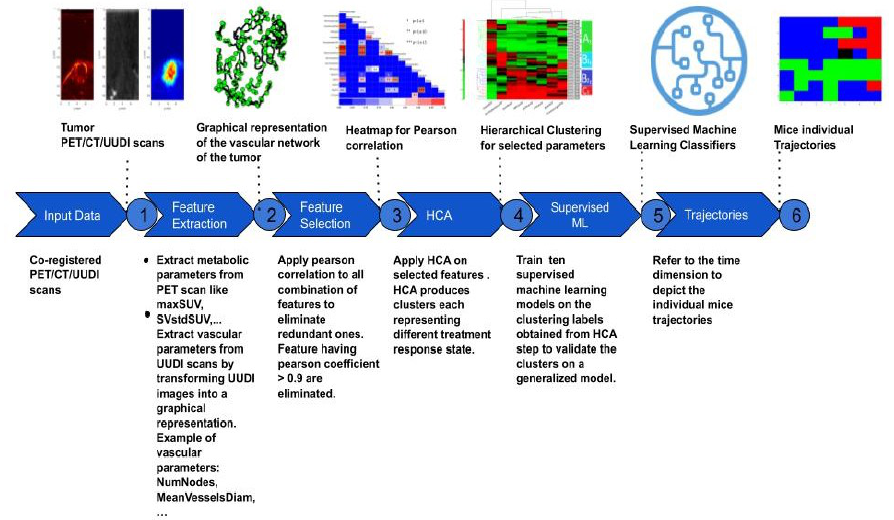
Figure 1. Process diagram showing the framework pipeline. Images were co-registered and processed to extract features describing the metabolic, vascular, and morphological components of tumor devel- opment. A Pearson correlation study was performed to remove redundant features. Longitudinal features were combined, and hierarchical clustering analysis was applied to obtain clusters and classes representing different stages of tumor evolution. The clusters and classes identified with HCA were used with 10 different supervised machine-learning classifiers for model generalization and final validation. Finally, time-wise concatenation of the identified stages was performed to form the individual trajectories of tumor evolution for each